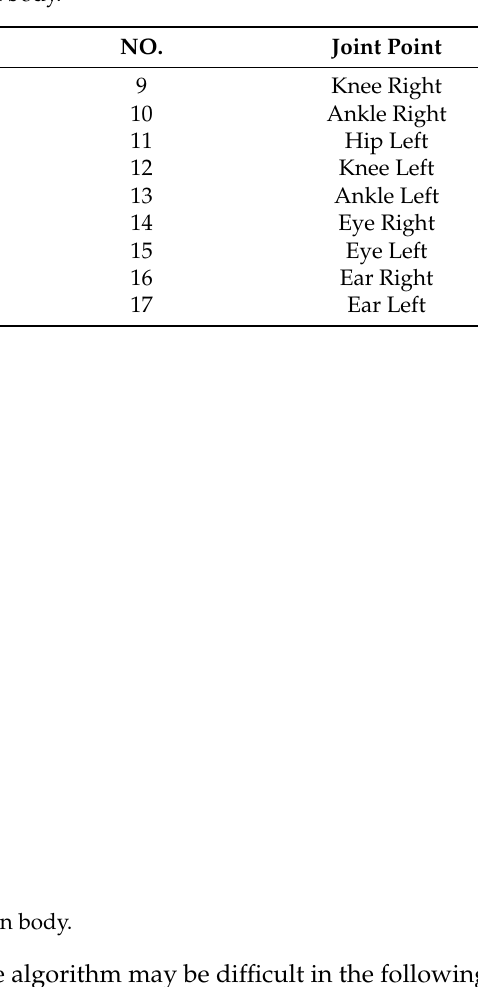
Figure 2. The architecture of our proposed model. Table 3. Eighteen joint points of the human body.